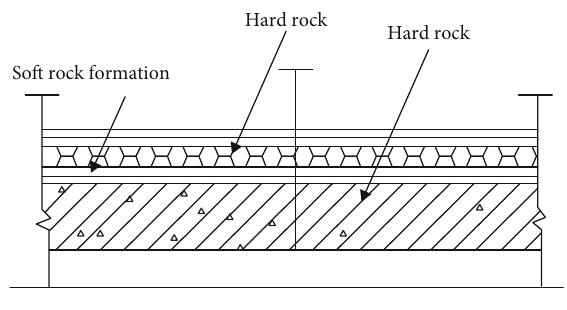
Figure 1: Suspension action of bolt